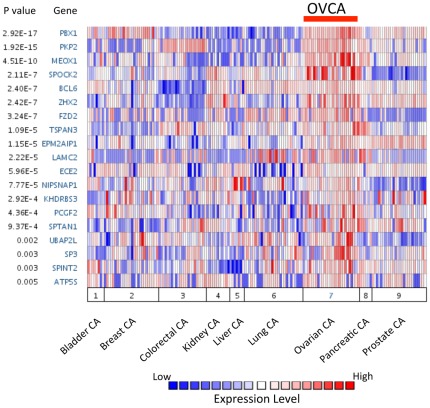
PBX1 and several of its direct target genes are over-expressed in ovarian cancer tissues.Oncomine meta-analysis was performed on a previously published gene expression microarray dataset containing nine different tumor types. Genes were ranked according to their over-expression in ovarian cancer and the top 18 genes were plotted.